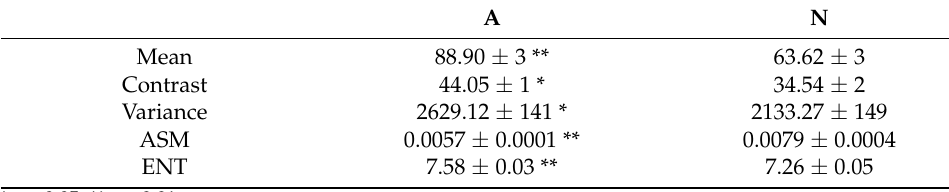
Figure 3. B-ultrasonic images of the rat hind limbs on day 21. ( a ) B-ultrasonic image of the A group. ( b ) B-ultrasonic image of the N group. In the figure, the red rectangle is the region of interest (ROI), the white rectangle is the scale bar of the ROI, the yellow arrow represents the focus depth of array transducer. The red rectangle in Figure 3 was used as the region of interest (ROI). The grayscale mean value, variance value, ASM, ENT, and contrast were identified from ROIs to quanti- tatively evaluate the state of muscle atrophy. The statistical results are shown in Table 1. group increased significantly, while the ASM decreased significantly (** p < 0.01). Table 1. Statistical analysis table of texture analysis on day